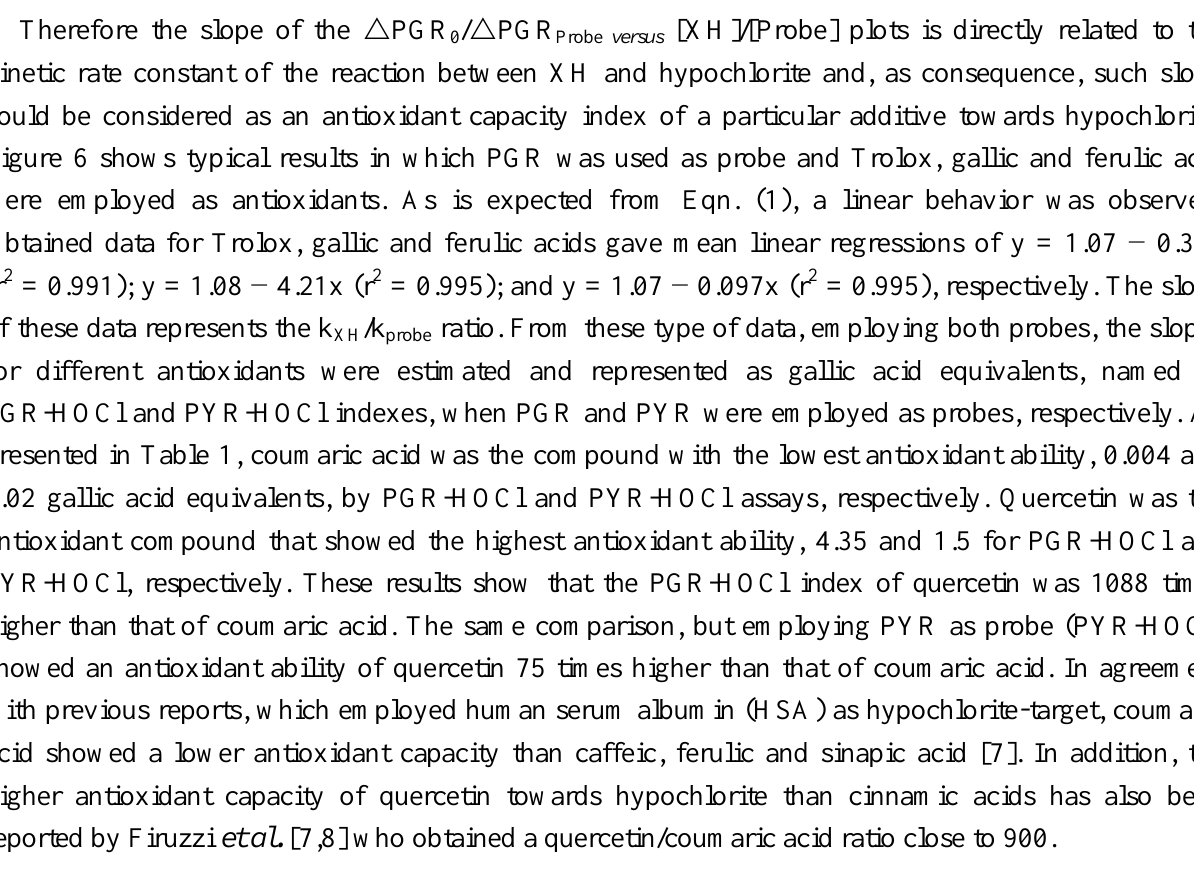
/  PGR with the [XH]/[PGR] ratio. XH = Trolox, 0 XH